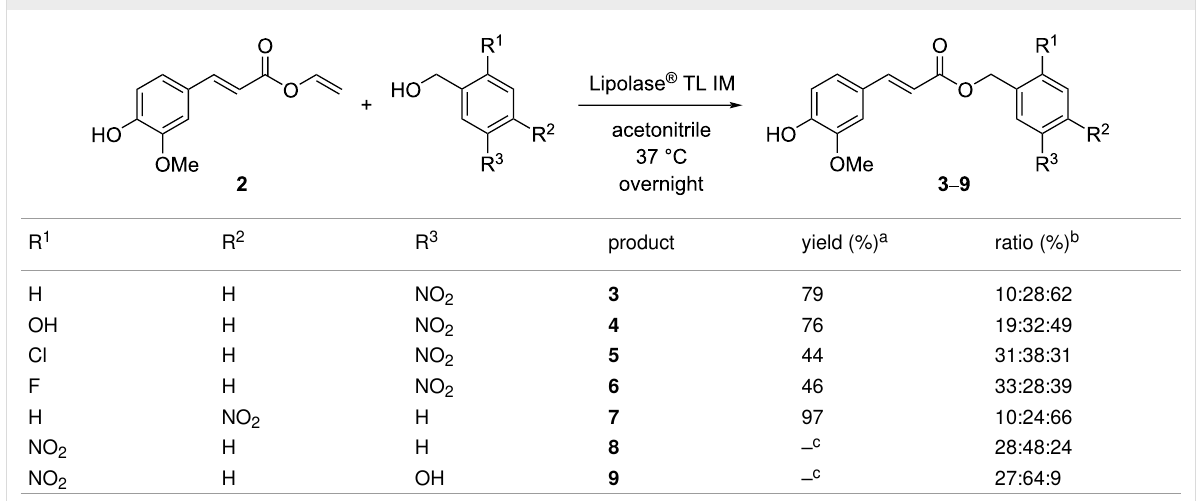
Table 1: Enzymatic transferuloylation of substituted nitrobenzylic alcohols.